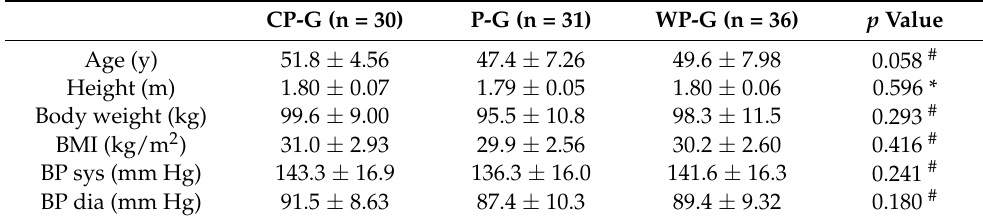
Table 1. Baseline data (T0) for the analyzed population (n = 97).